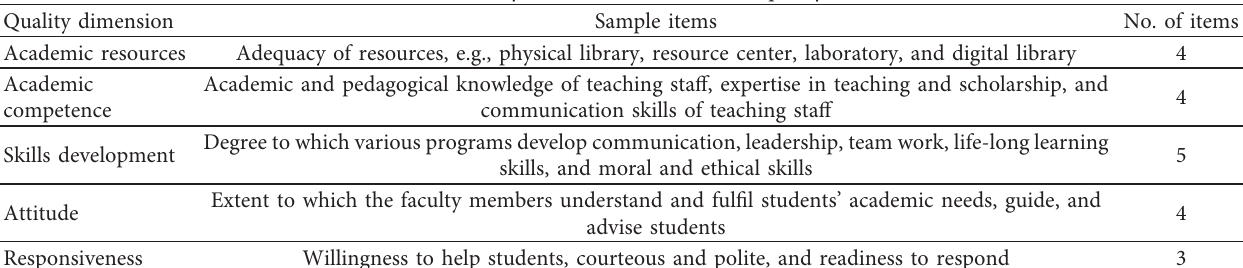
Table 1: The survey instrument for academic quality